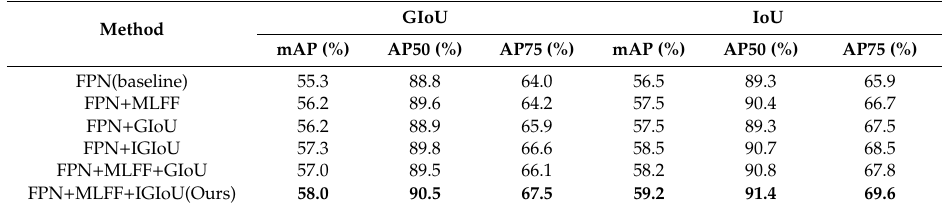
Table 1. Comparison with baseline methods on NWPU VHR-10 dataset in terms of six evaluation metrics. Bold fonts denote the best